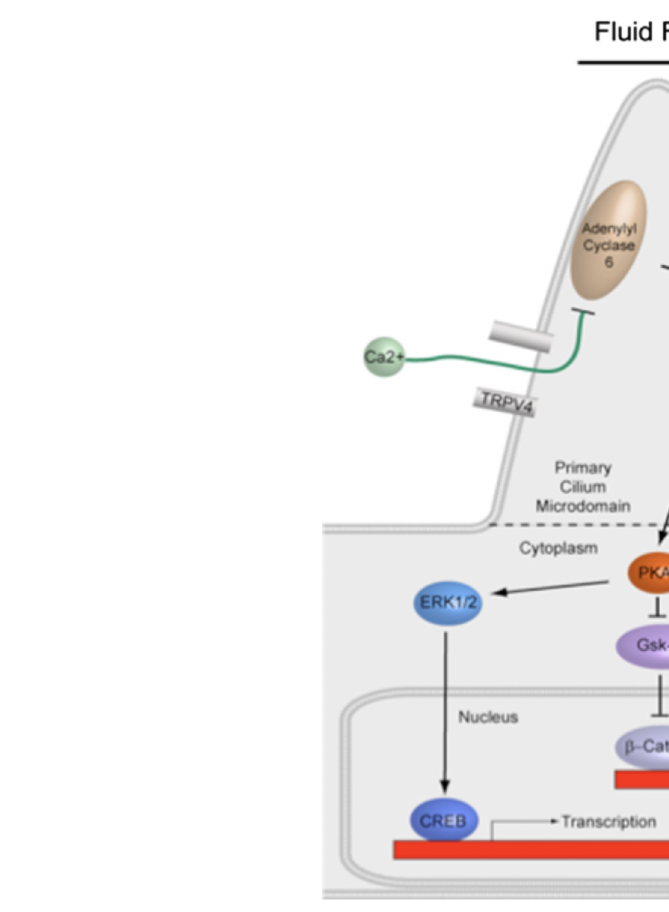
GSK-3 β -mediated degradation of the transcription factor β -Catenin. Both pathways have been shown to be involved in fluid flow mechanotransduction in